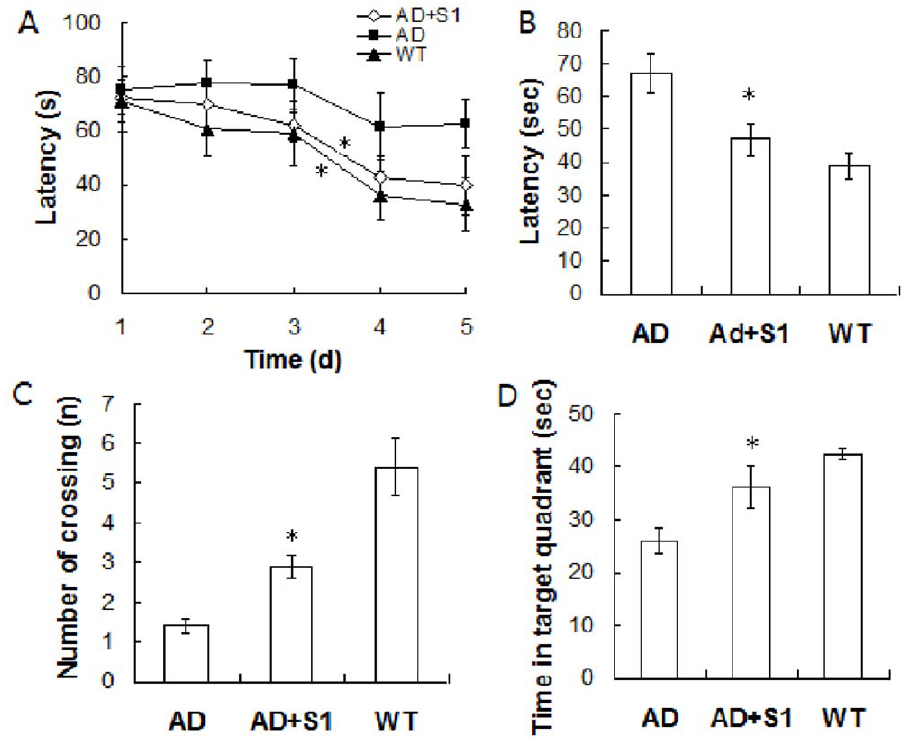
Figure 6. Peptide S1 attenuates spatial memory deficits. (A) APP/PS1 mice were administered S1 (n=9) or vehicle (n=9) by i.c.v infusion four times. Littermate control mice (WT, n=10) were administered vehicle. Each mouse was given two 90 s trials per day for five consecutive days to find the hidden platform in a Morris water maze. The recorded data were analyzed and showed the changes of latency to find the hidden platform over 5 days of the training phase (AD mice treated with S1 or WT mice compared with AD mice control, *, P , 0.05). (B) Effect of S1 on escape latency during the memory test in the MWM probe trial without a platform. (C) Effect of S1 on the number of crossings (the mice crossed the position where the platform was placed during learning sessions). (D) Effect of S1 on the time spent in the target quadrant during the memory test in the MWM probe trial (compared with AD control mice, *, P , 0.05).